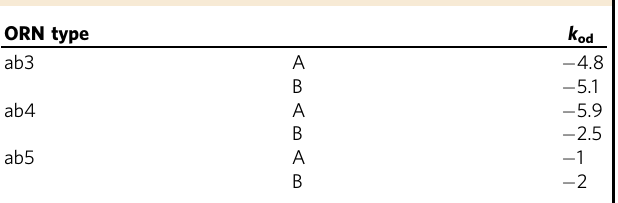
Table 2 ORN-speci fi c odorant sensitivities ORN type